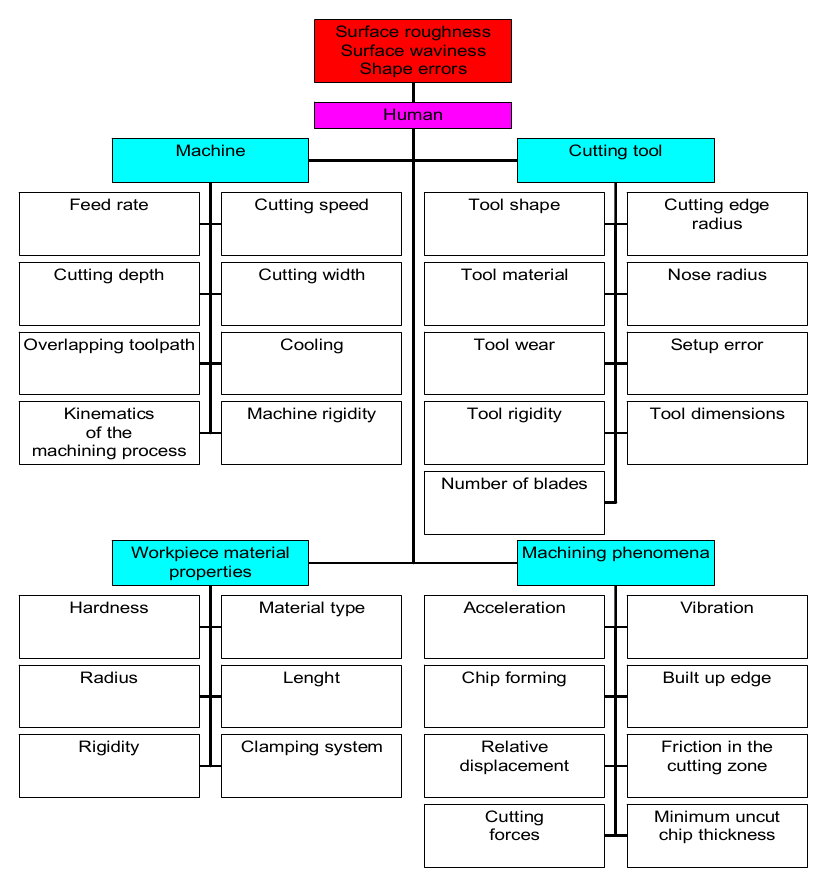
Figure 1. Factors affecting the geometric structure of the surface during the machining process.